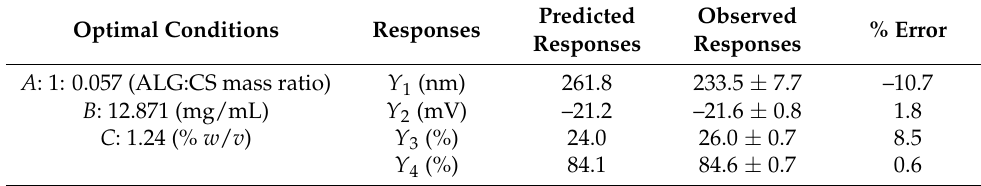
Predicted Observed % Error Responses Responses